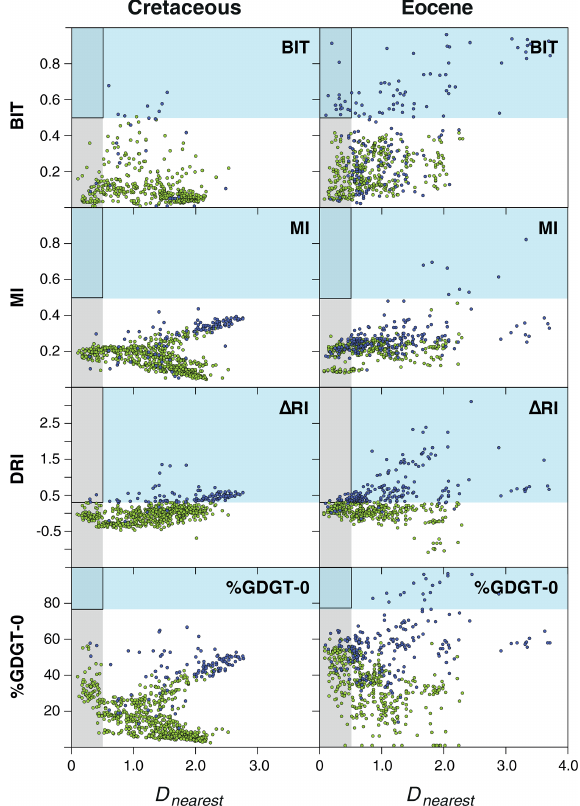
Figure 15. Comparison of D nearest against standard screening in- dices: BIT and MI indices, (cid:49) RI and %GDGT-O for the Eocene (In- glis et al., 2015) and Cretaceous (O’Brien et al., 2017) datasets. Blue shaded regions show the standard failure thresholds for these indices (see text); grey shaded region highlights data that are below the D nearest threshold of 0.5. Data points that fail any one of the standard screening indices are shown in blue, and data points that pass all standard screening indices are shown in green. The outlined black box is the region of data that fails traditional screening indices but passes D nearest ( < 0.5).